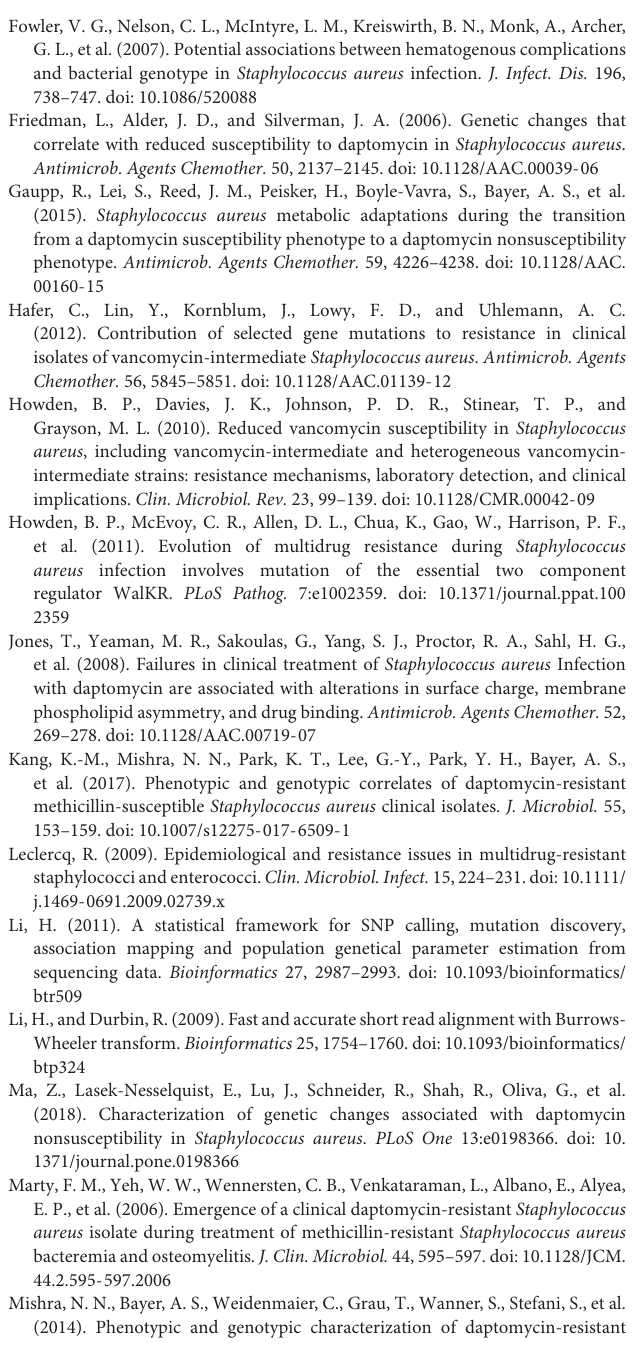
populations and display the same dynamics (i.e., SNPs appear at the same time and change in frequency at the same rate and at the same dosages). TABLE S1 | SNPs present in the parental DAP-S isolate of N315 in comparison to the NCBI Refseq N315 isolate. These changes were detected in our BEI parental N315 strain and all descendant populations, except for the mutation at position 939485, which is not present in Population C. Annotations associated with noncoding SNPs are for the nearest coding sequence.